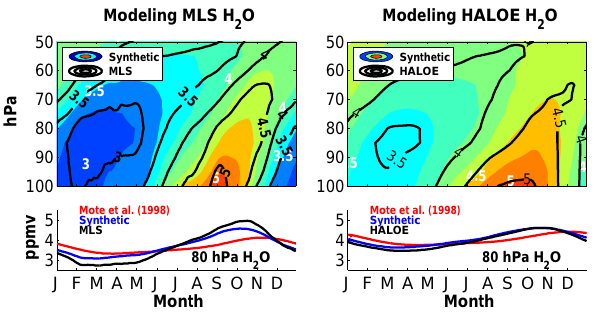
Figure 6. The best synthetic 1-D transport model solutions of the MLS (left; a = c = 1, b = 4) and HALOE (right; a = c = 1, b = 5 . 5) tape recorders in pressure coordinates (corresponding to the white stars in the left and middle panels of Fig. 5, respectively). The bottom panels show the annual cycle of the water vapor mixing ratio at 80hPa produced using the (Mote et al., 1998) control values (red), the above synthetic values (blue), and the MLS and HALOE observations (black).